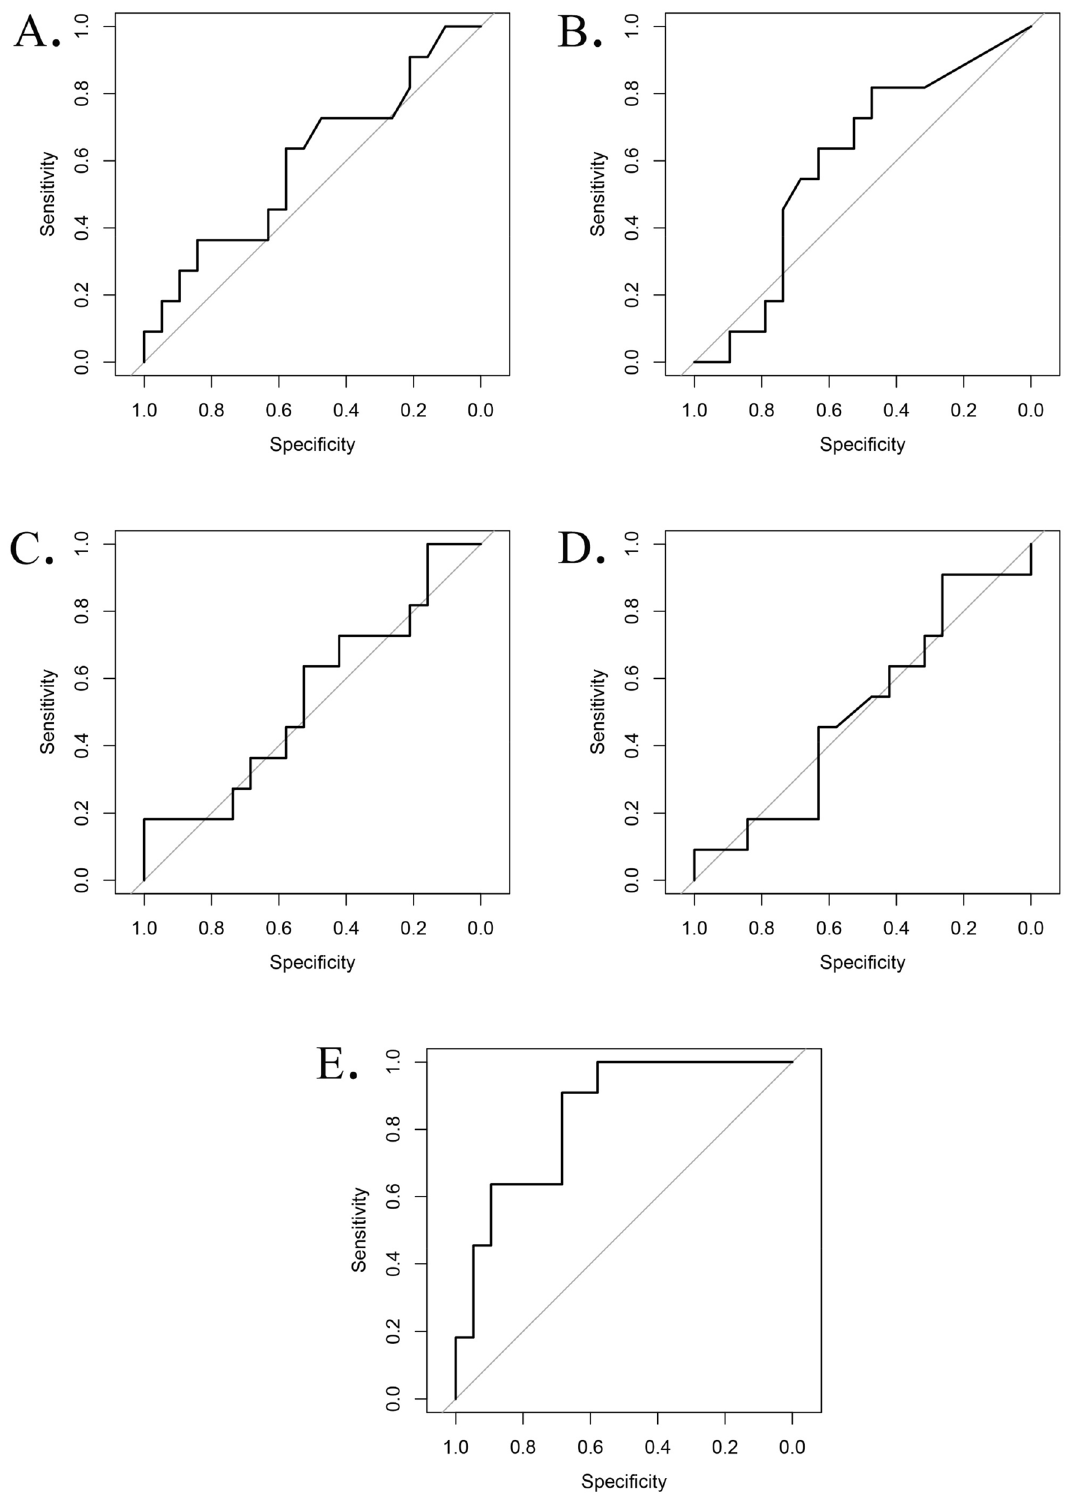
Figure 5. ROC curves of models using four feature reduction/fusion methods. ( A ) ROC curve for PCA based fusion method, AUC = 0.60, specificity = 0.58, sensitivity = 0.64. ( B ) ROC curve for Boruta based feature reduction method, AUC = 0.60, specificity = 0.47, sensitivity = 0.48. ( C ) ROC curve for CPH based feature reduction method, AUC = 0.55, specificity = 1.00, sensitivity = 0.18. ( D ) ROC curve for LASSO based feature selection method, AUC = 0.50, specificity = 0.26, sensitivity = 0.91. ( E ) ROC curve for the proposed risk-score based feature fusion method, AUC = 0.84, specificity = 0.68, sensitivity =